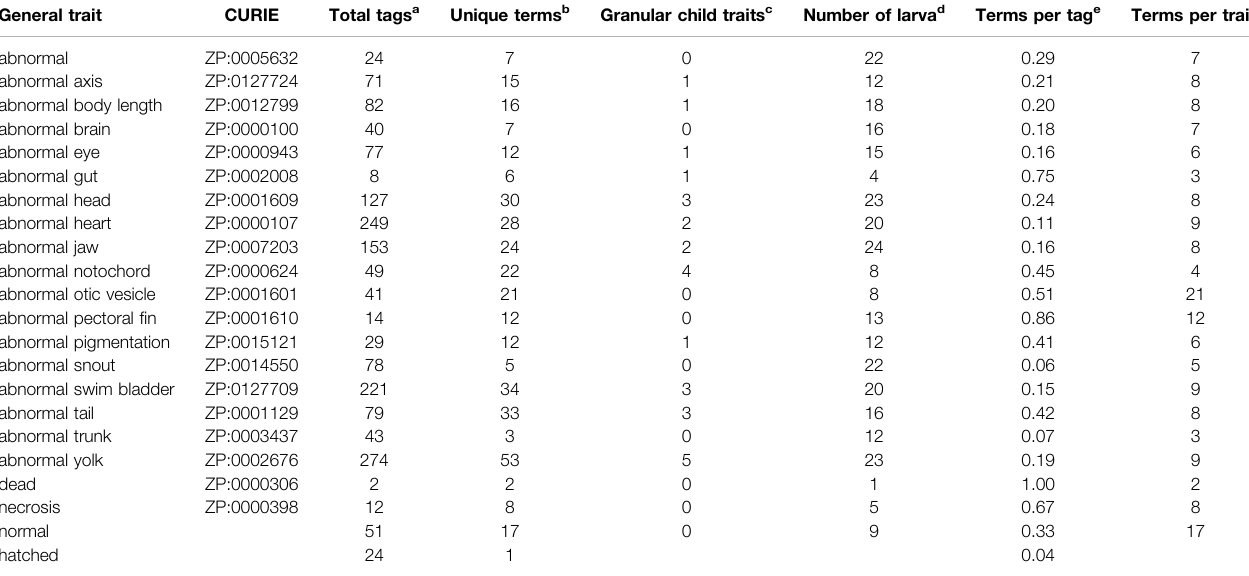
TABLE 2 | Survey 1: analytical summary. General trait